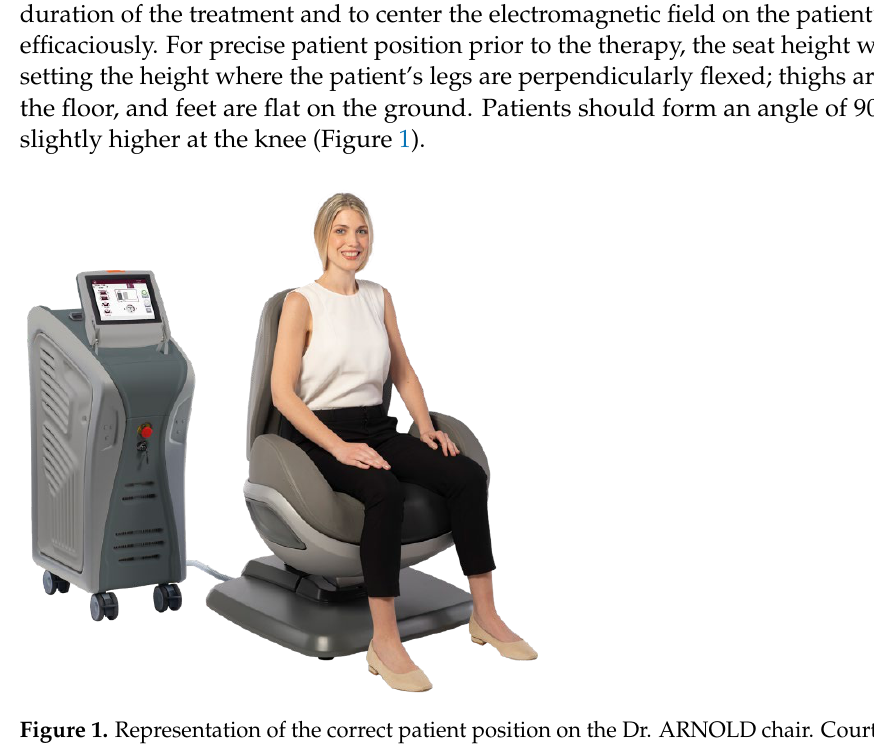
Figure 1. Representation of the correct patient position on the Dr. ARNOLD chair. Courtesy of DEKA M.E.L.A company.